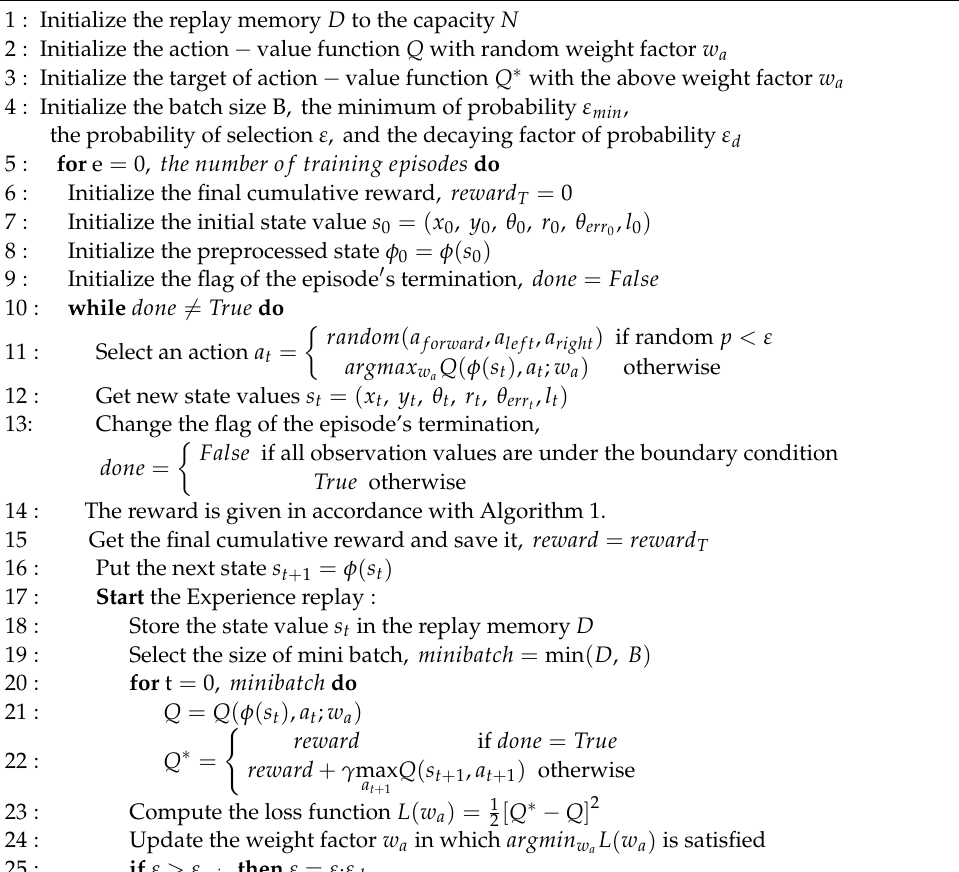
Algorithm 2 Failure-safe algorithm using Deep Q-learning